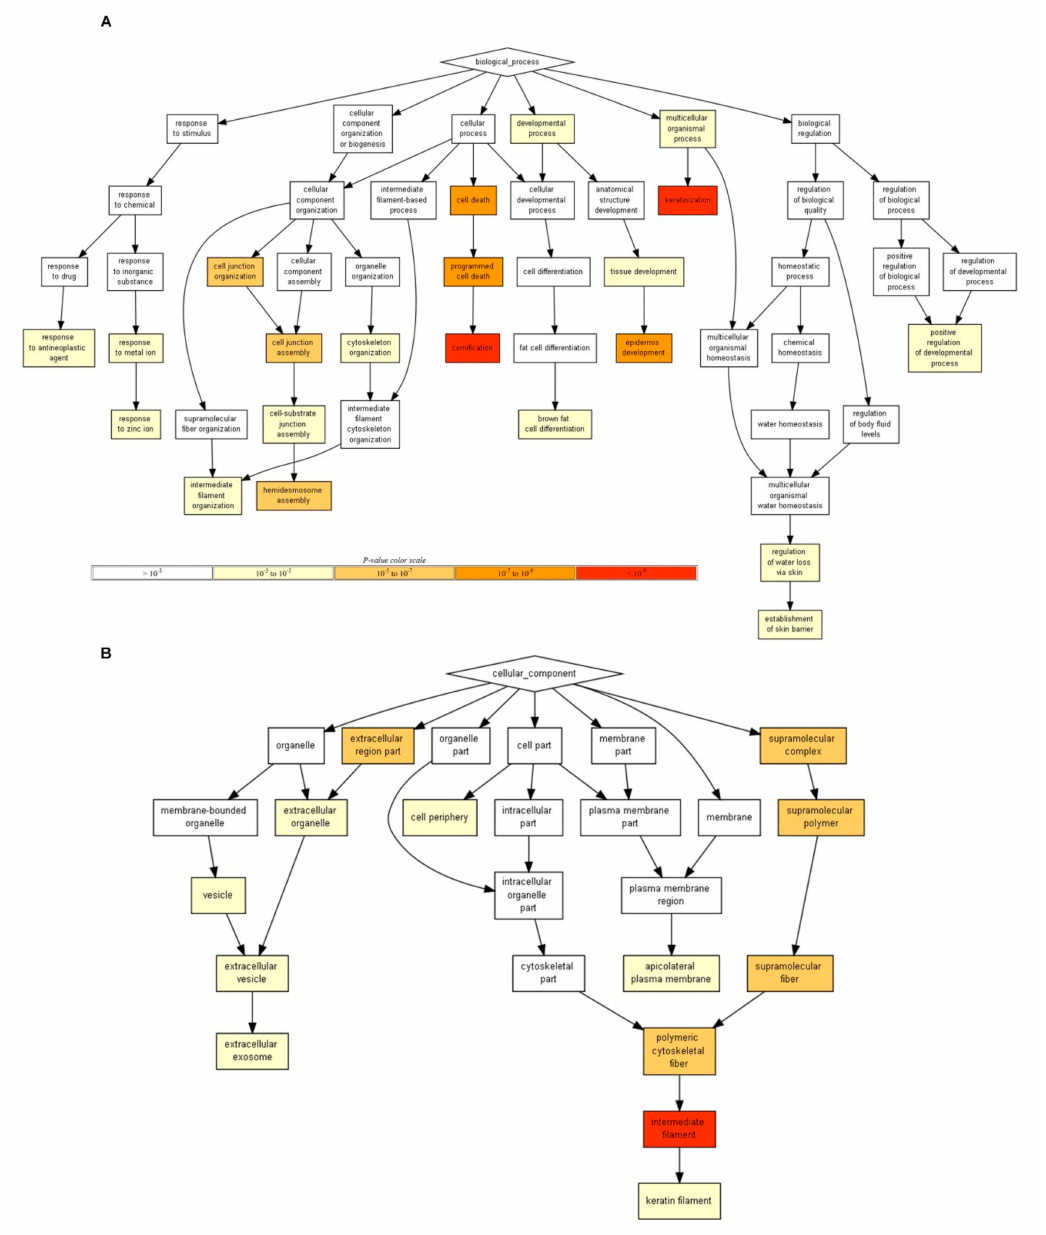
Figure 6. Hierarchical structure of identified enriched GO terms for up-regulated human genes in response to LACCE. Directed acyclic graphs (DAGs) visualize hierarchical structure of identified enriched GO terms for up-regulated genes upon LACCE treatment according to biological process ( A ) and cellular component ( B ). Each GO term is indicated by di ff erent box color based on p -value. Detailed information for identified GO terms can be found in Table